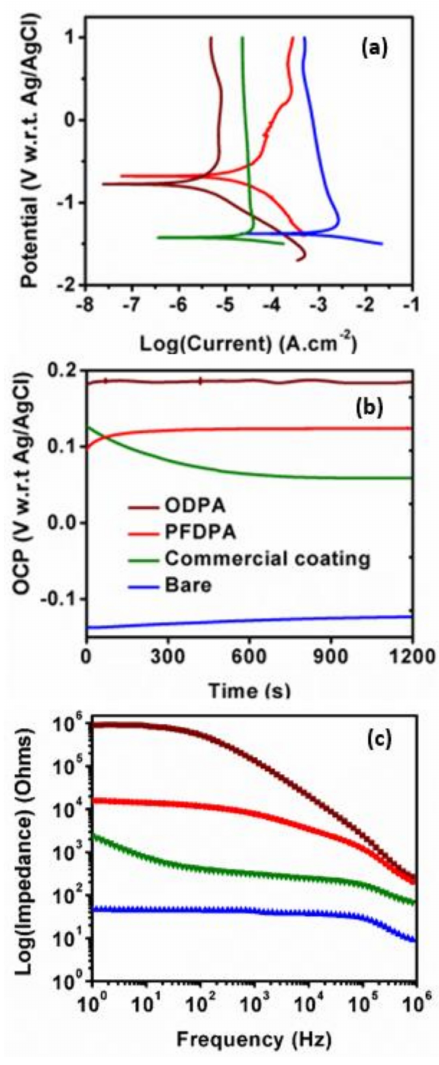
Figure 8. ( a ) Tafel plots, ( b ) plots of open circuit potential (OCP) versus time, and ( c ) Bode plots for